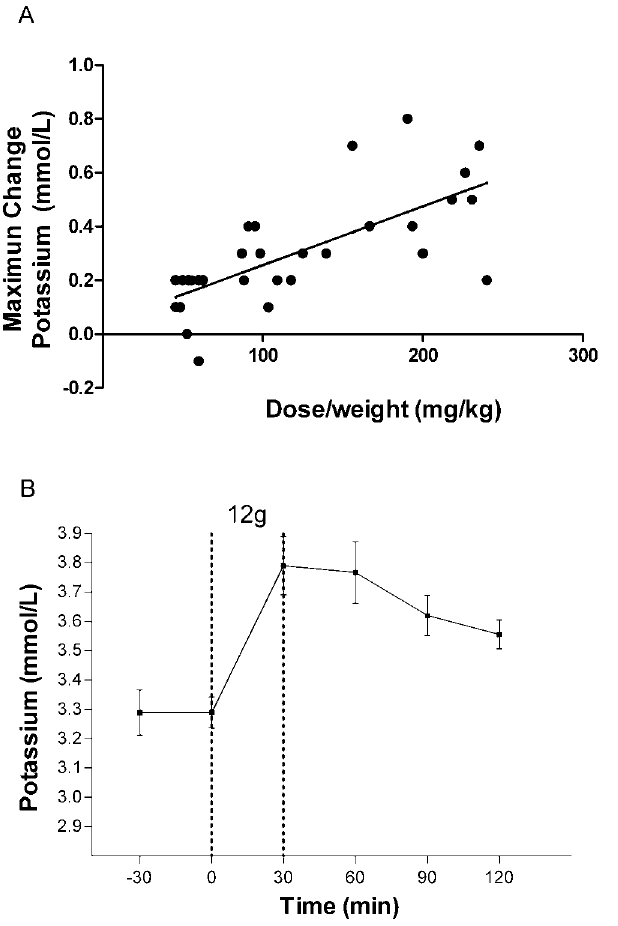
Figure 2. Effects of L-arginine hydrochloride infusion on whole blood potassium concentrations. Figure 2A: Relationship be- tween dose/weight (mg/kg) of infused L-arginine and the maximal increase in whole blood potassium concentration at any time during or in the two hours following infusion (n=30; r=0.73, p , 0.001). Figure 2B: Whole blood potassium concentrations of patients before and after 30 minute administration of the highest dose of L-arginine (12 g; n=10). Shaded area indicates time of L-arginine infusion. Dots and bars indicate mean 6 SEM.